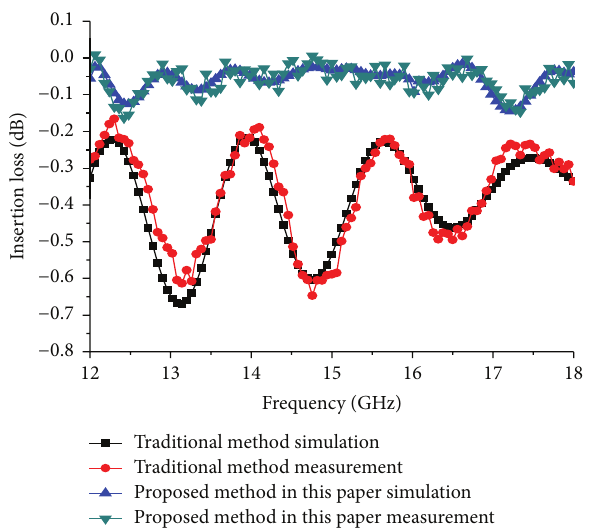
Figure 1: Simulated and measured insertion loss 𝑆 21 of the transi- tion.